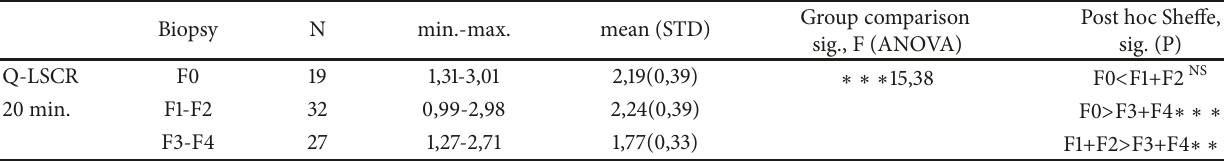
Table 3: The liver signal intensity Q-LSCR parameter differences at 20 minutes post-Gd-EOB-DTPA injection among different categories of fibrosis. N